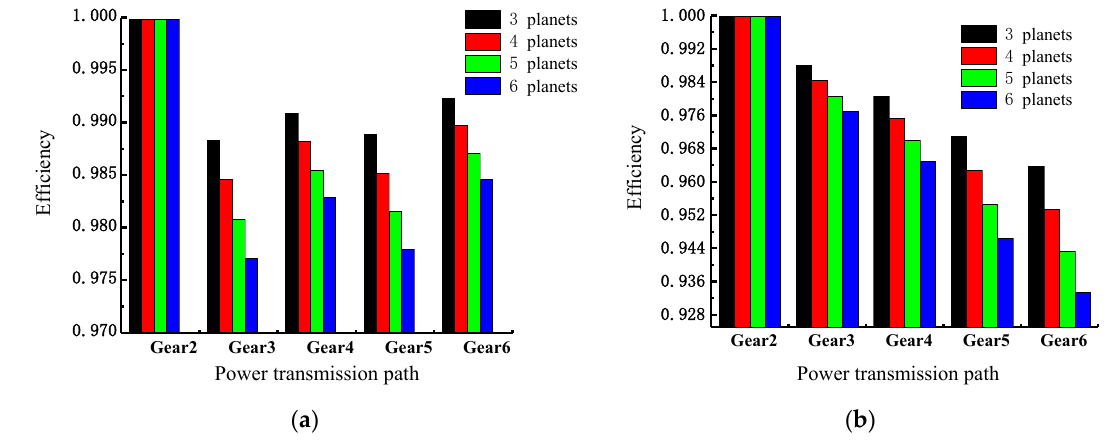
Figure 10. Variation of efficiency along the transmission path using hypergraph method. ( a ) Three planetary gears; ( b ) four planetary gears; ( c ) five planetary gears; ( d ) six planetary gears.